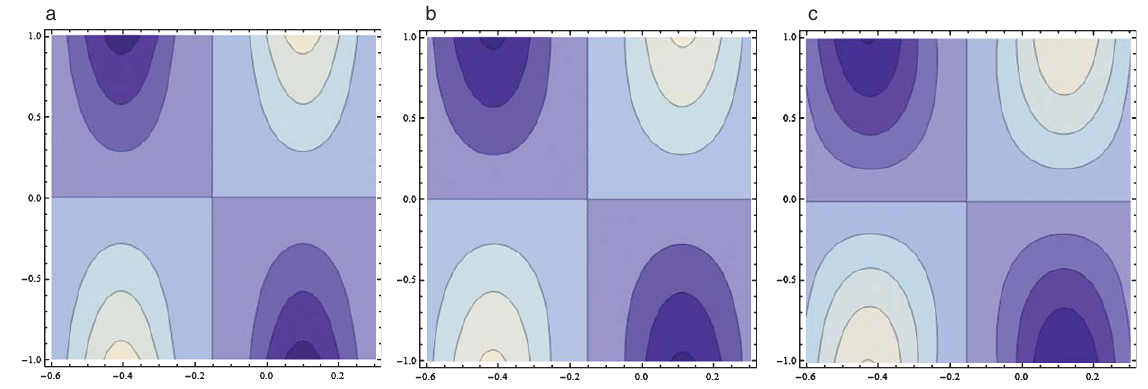
Fig. 6. Variation of α on ψ for E 1 = 0 . 7 , E 2 = 0 . 2 , E 3 = 0 . 1 , E 4 = 0 . 01 , E 5 = 0 . 3 , (cid:11) = 0 . 2 , M = 2 , t = 0 . 1 , β = 0 . 02 , when (a): α = 0 . 5, (b): α = 1 , (c): α = 1 . 5.